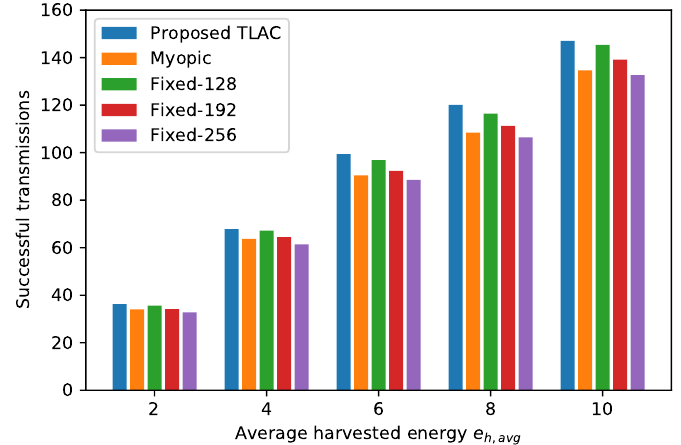
Figure 19. The number of successfully transmitted data packets according to the harvested energy, compared with the fixed key-length encryption